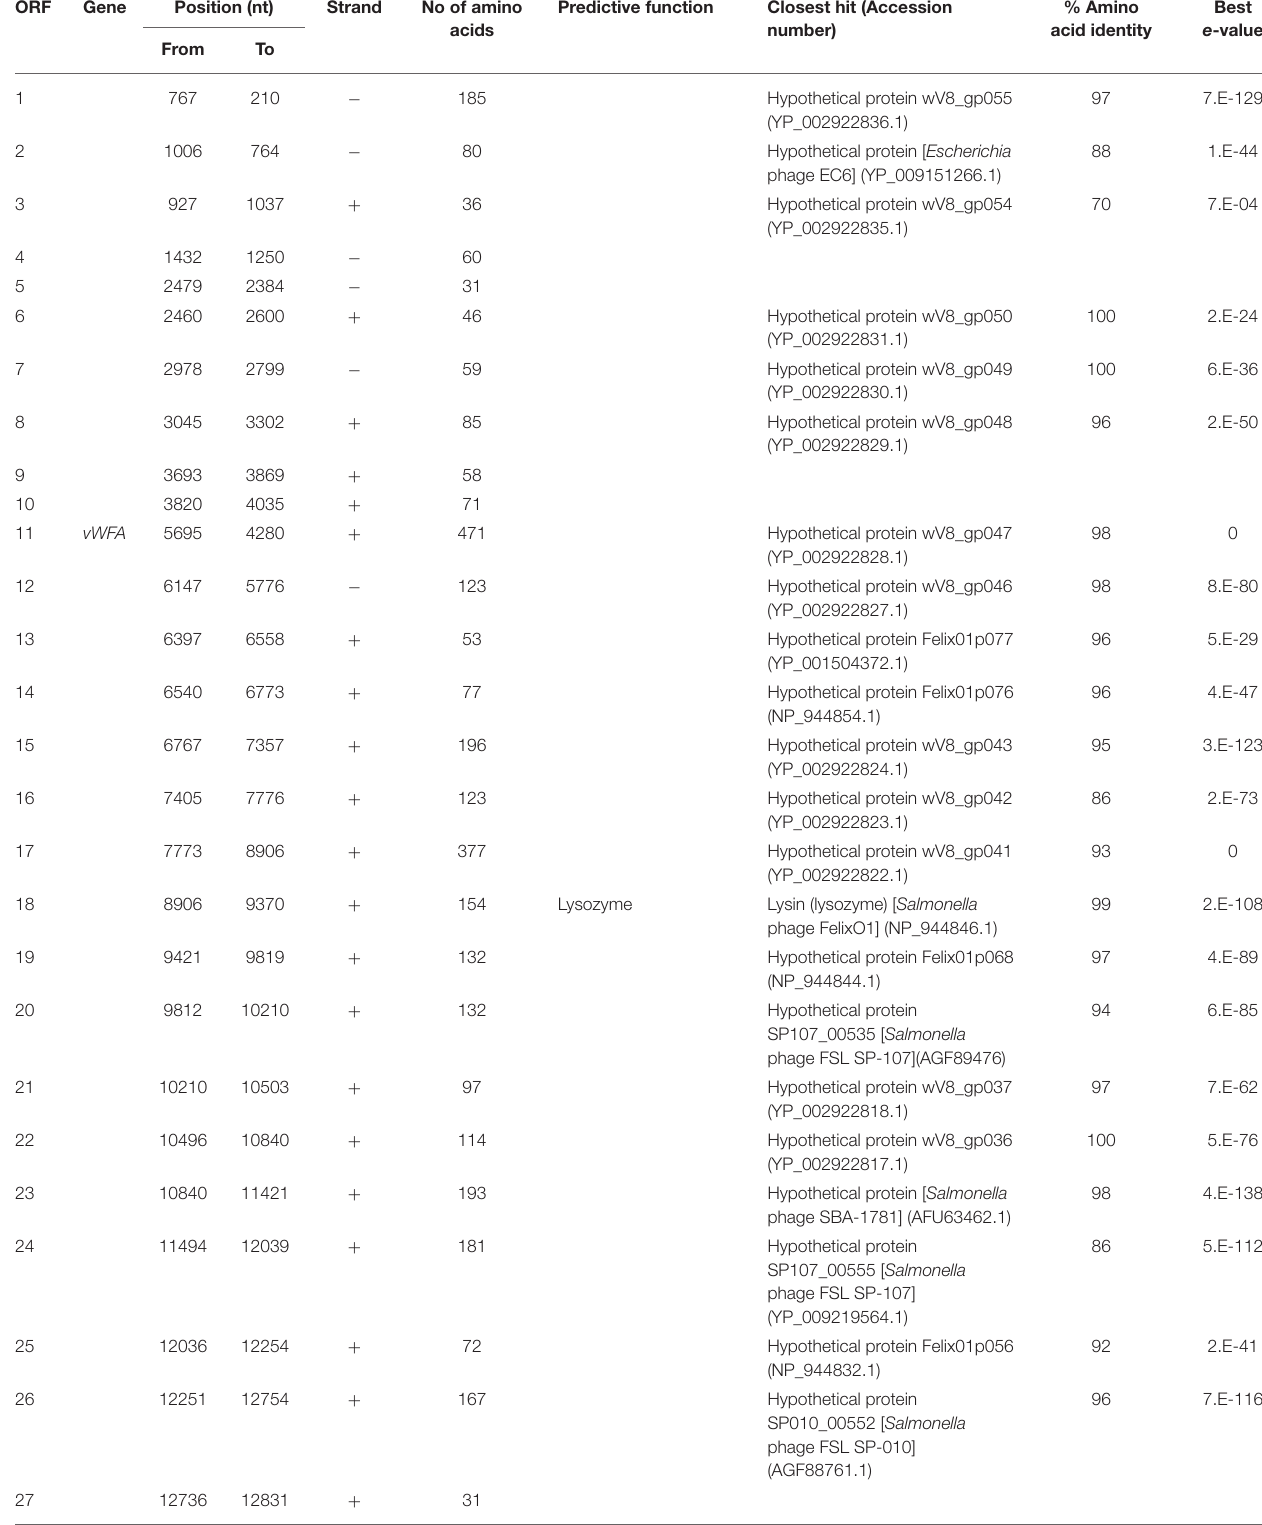
TABLE 3 | Features of bacteriophage UAB_Phi87 genome, ORFs, gene products, and functional assignments. ORF Gene Position (nt) Strand No of amino